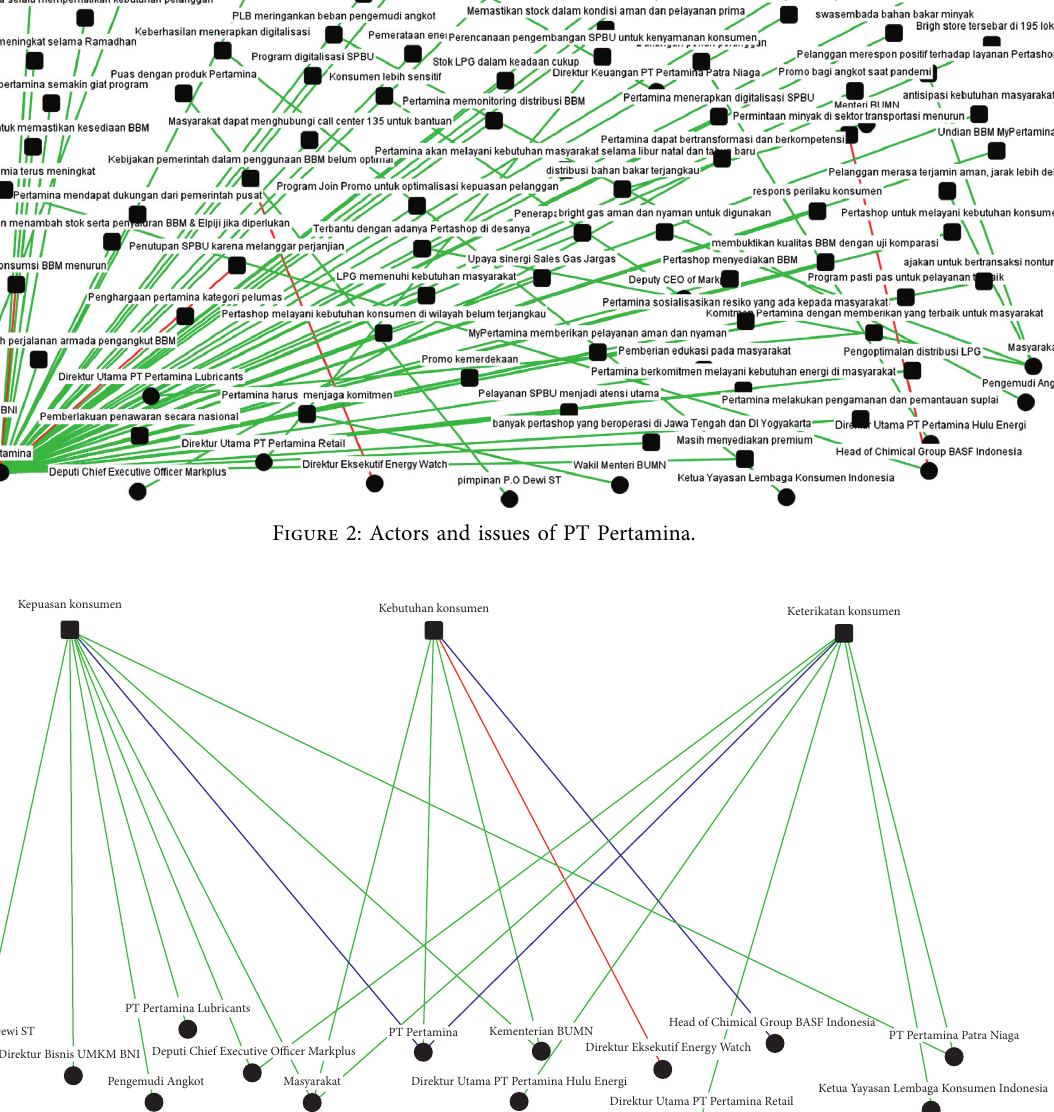
Figure 3: Mapping of PT Pertamina’s actors and